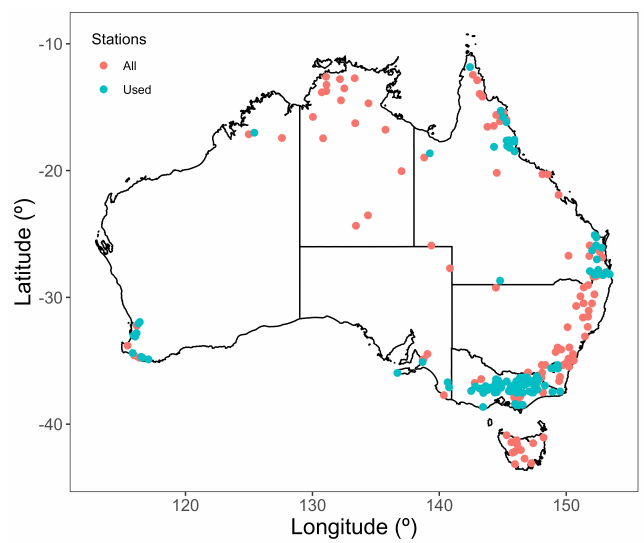
Figure 1. Map of all the Hydrological Reference Stations available in Australia and those selected for this study. Stations were selected if the streamflow record had over 90% of the highest quality